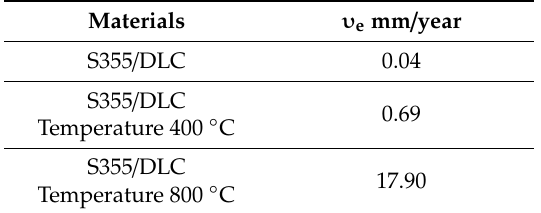
Table 4. Electrochemical corrosion rate of the S355 steel with a diamond-like carbon coating, before and after heat treatment in air atmosphere at 400 and 800 ◦ C, the electrolyte contained 1.2 M Cl − and 0.2 M OH − , at a temperature of 25 ◦